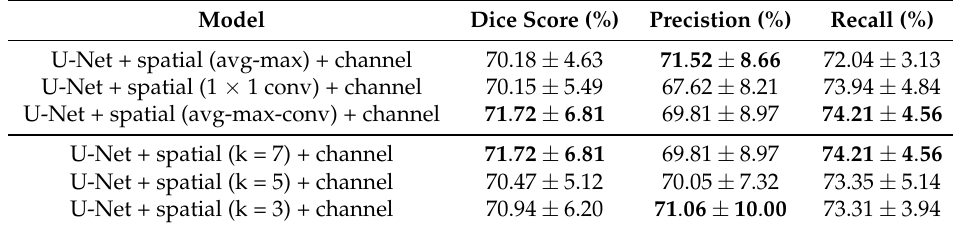
Table 3. Comparison of different spatial methods on CVC-ClinicDB dataset (best results marked